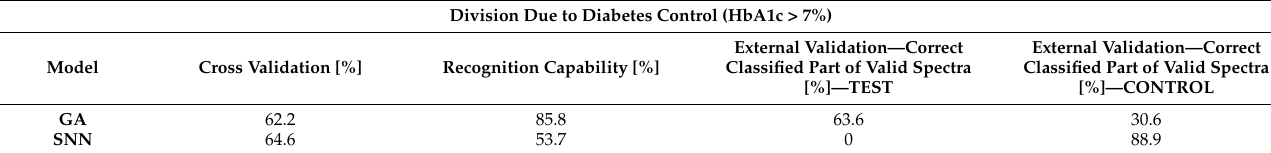
Table 5. Division due to diabetic control (HbA1c > 7%) .